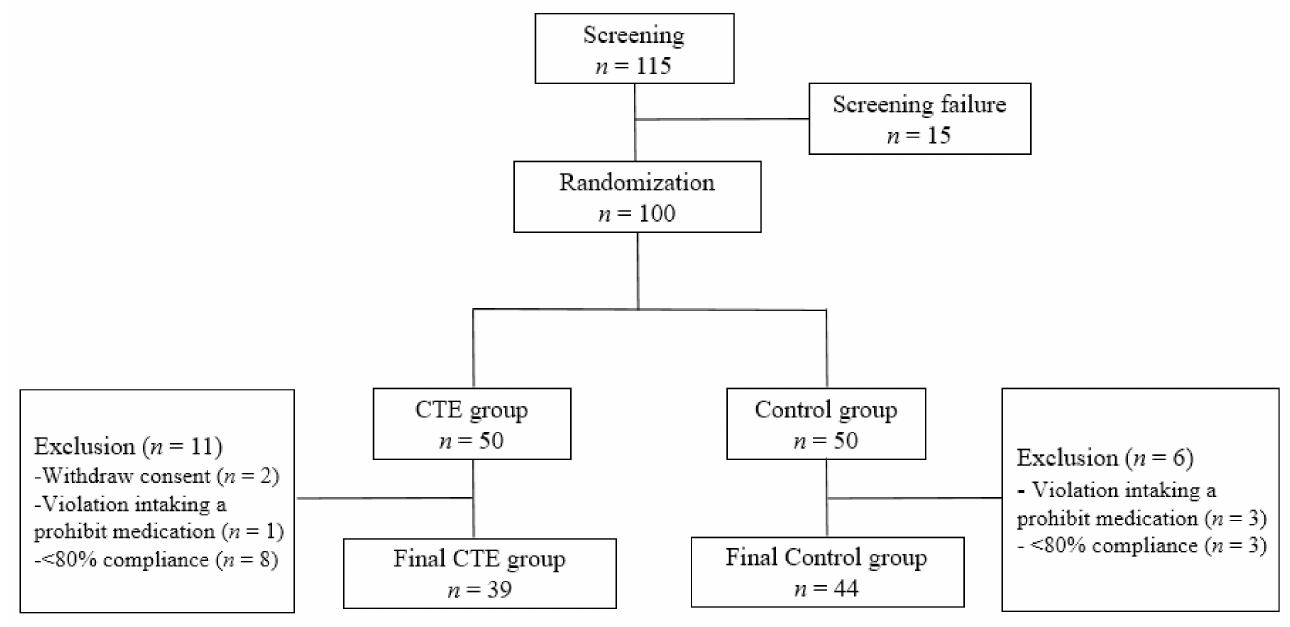
Figure 1. Flow chart of the study population.